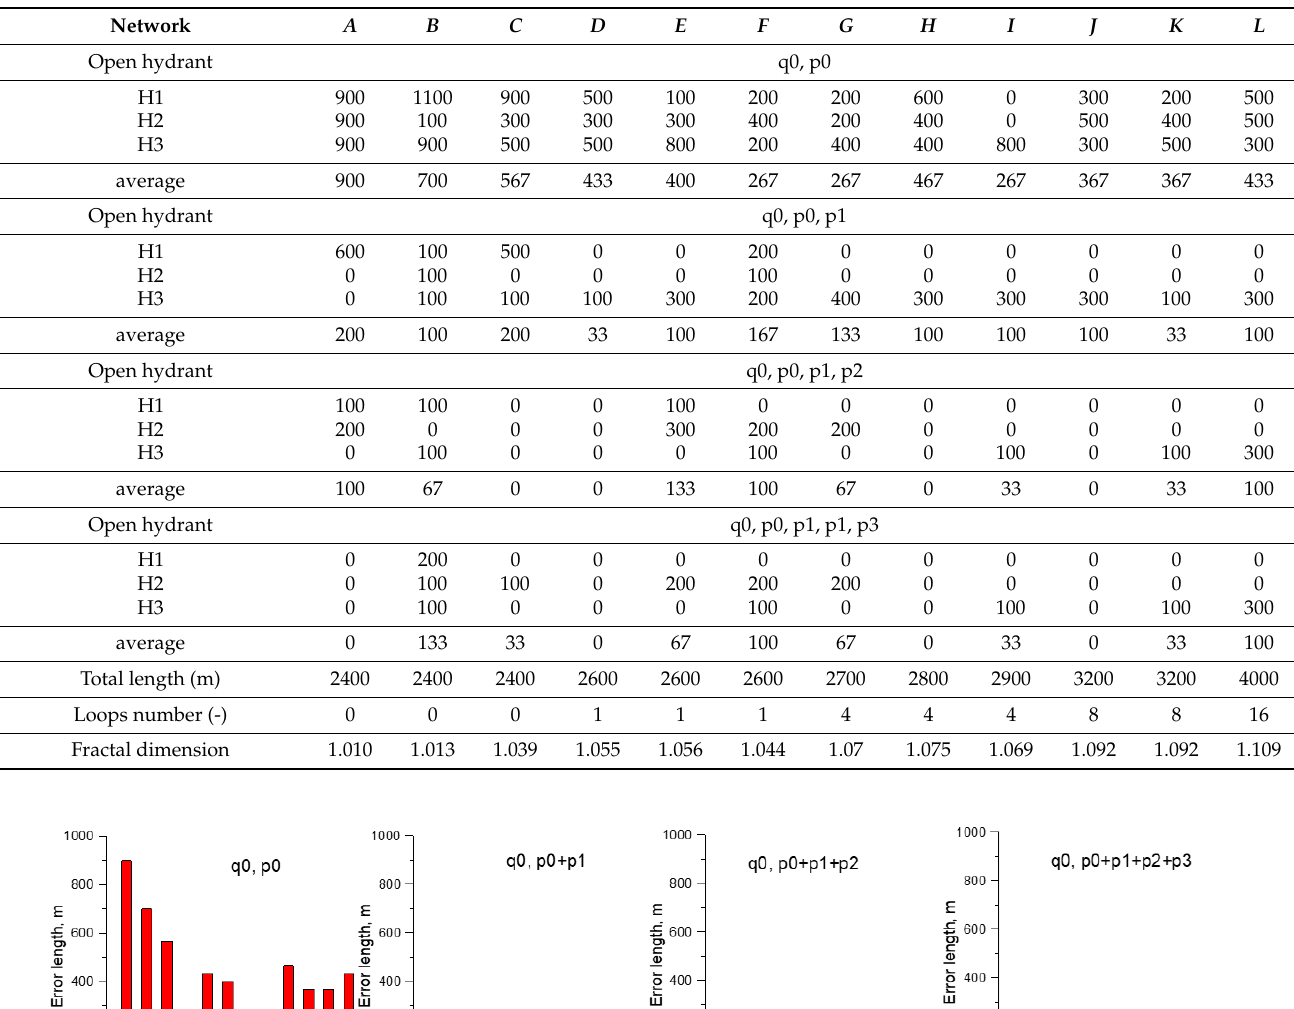
Table 2. Calculated length of the error (m) and total pipe length, number of loops, and fractal dimensions for all A – L networks.